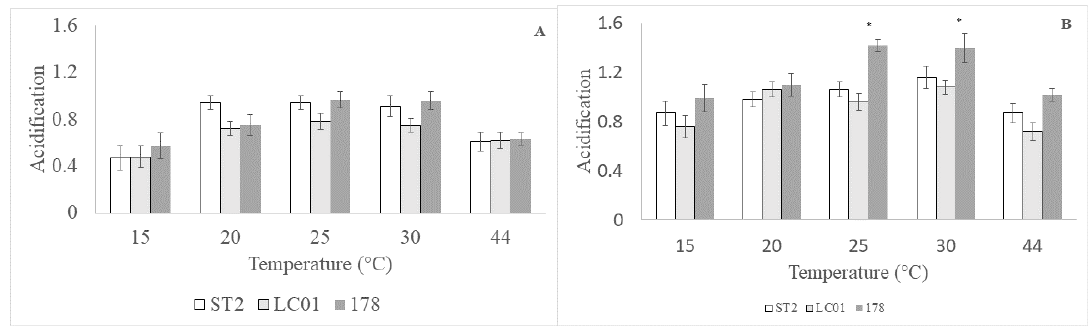
Figure 1. Acidification ( Δ pH) performed by Lb. sakei ST2, Lb. casei LC01 and Lb. plantarum 178 in a synthetic medium simulating meat after 6 ( A ) and 48 h ( B ). Mean ± standard deviation. The symbol “*” indicates a significant difference (two-way ANOVA and Tukey’s test, p < 0.05). Table 1. Two-way analysis of variance performed on the acidification scores after 6 and 24 h—ns, not significant; * p < 0.05; ** p < 0.01.